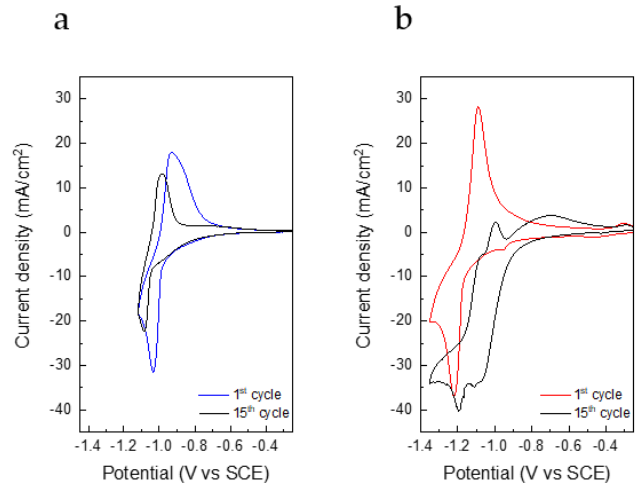
Figure 5. CV at 0.5 mV/s of NTP electrodes in ( a ) Na 2 SO 4 and ( b ) Li 2 SO 4 .